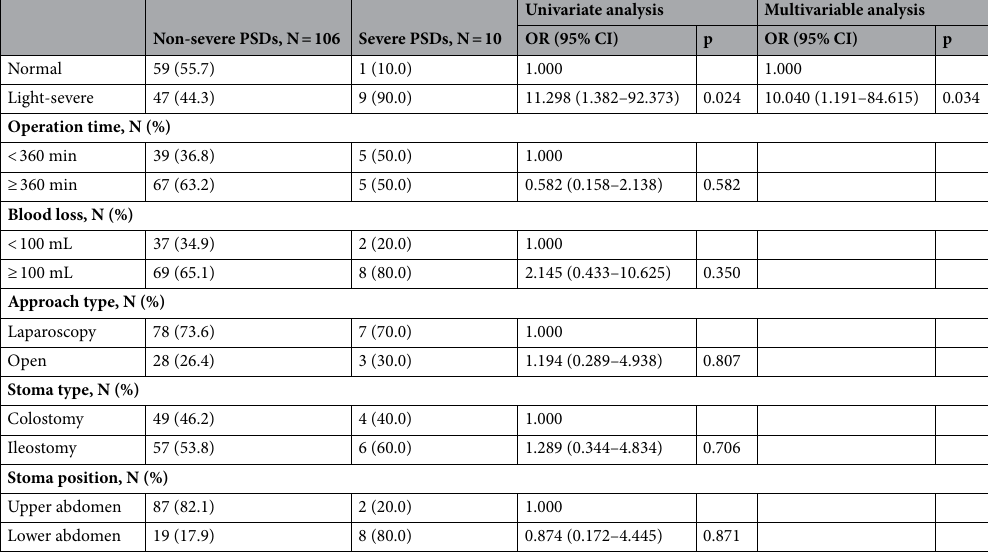
Table 3. Risk factors for severe peristomal skin disorders. PSDs peristomal skin disorders, OR odds ratio, CI confidence interval, PNI prognostic nutritional index, GNRI geriatric nutritional risk index, CONUT Controlling Nutritional Status.